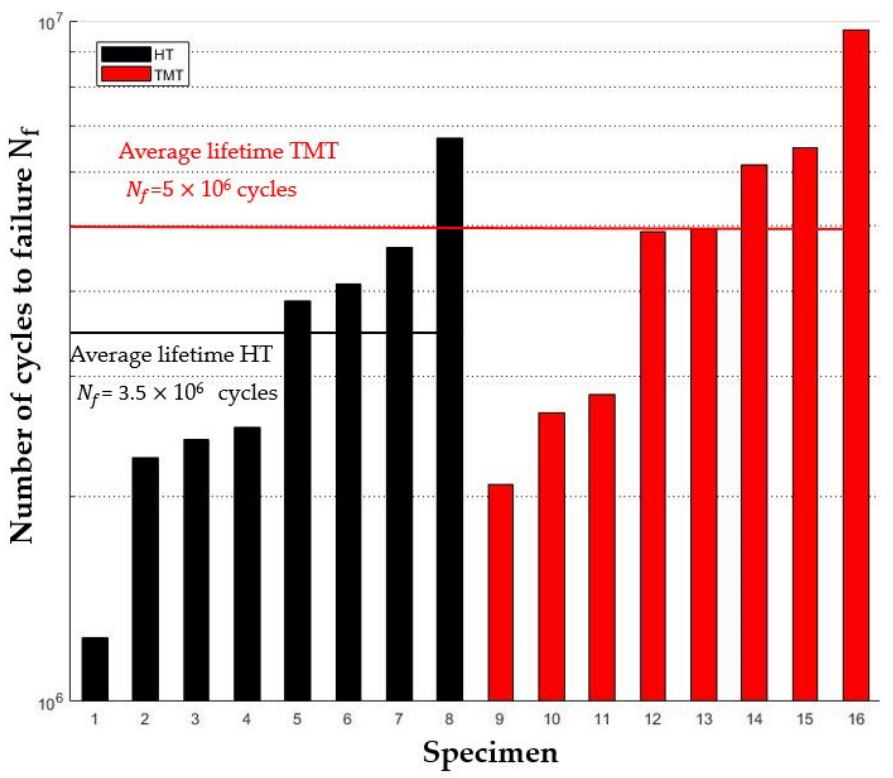
Figure 3. Fatigue lifetime analysis of HT and TMT specimens at given stress amplitude of 775 MPa.